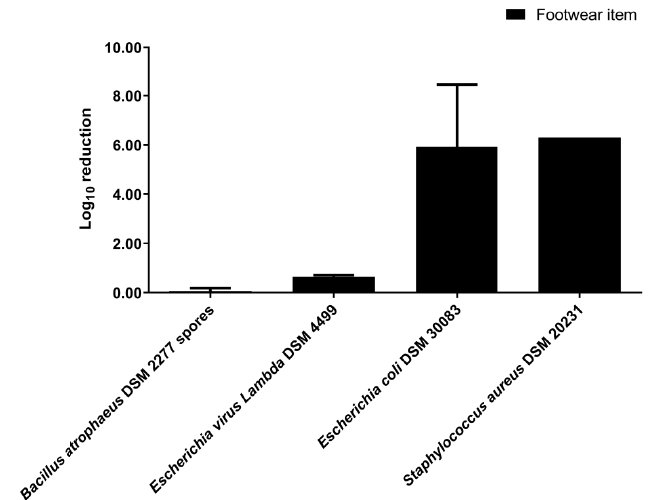
Figure 4. Log 10 reduction achieved in disinfection of a footwear item by nebulization in a 0.08 m 3 closet. VIRCOV BAC 360 disinfectant was used at 1/3 ( v / v ) dilution. The indicators tested were B. atrophaeus DSM 2277 spores, bacteriophage Lambda DSM 4499, E. coli DSM 30083, and S. aureus DSM 20231. The disinfection time consisted of 2 min of disinfectant nebulization plus 5 min of rest without nebulization. The error bars in the graph represent the standard deviation of the mean of three replicates ( n = 3).